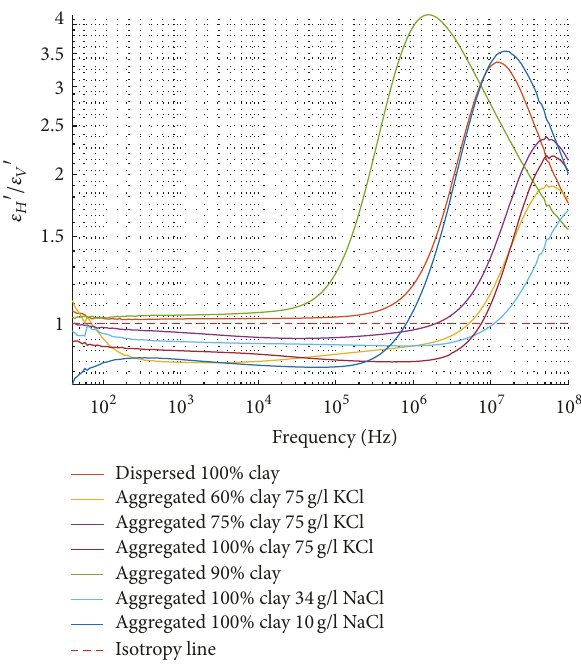
Figure 8: Dielectric anisotropy versus frequency in brine saturated and fresh water